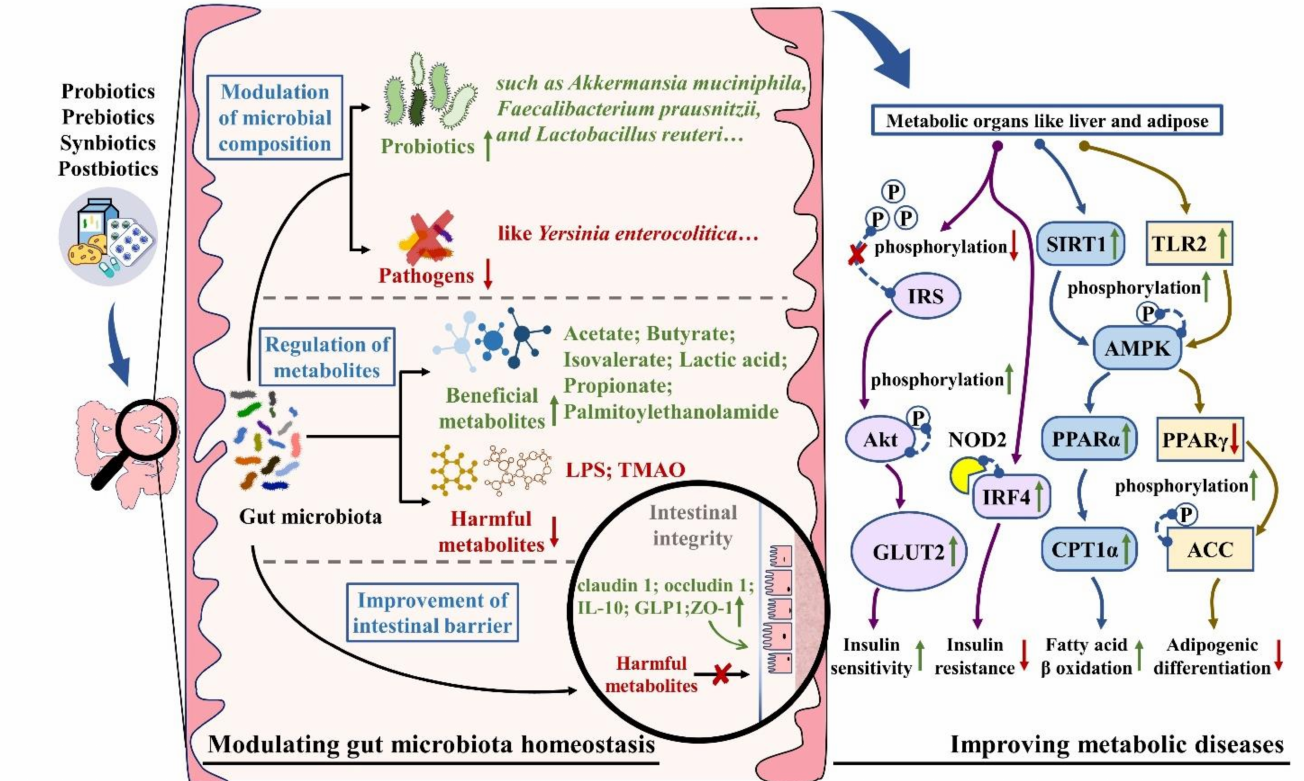
Figure 1. Mechanisms of PPSP on metabolic diseases targeting gut microbiota. PPSP directly alleviate metabolic diseases by regulating the abundances of beneficial and harmful bacteria. Besides, PPSP indirectly ameliorate metabolic diseases by promoting the production of acetate, propionate, butyrate, isovalerate, lactic acid, and palmitoylethanolamide, while suppressing the production of LPS, TMAO and reducing the bile acid pools. Moreover, the improvement of intestinal barrier function played an important role in attenuating metabolic diseases, with upregulating claudin 1, GLP1, IL-10, occludin 1, and ZO-1 expressions. These mechanisms collectively improve the whole metabolic system by targeting several pivotal molecular, such as upregulating IRS1-Akt-GLUT2, SIRT1-AMPK-PPAR α -CPR1 α , TLR2-PPAR γ -AMPK, and NOD-IRF4 signaling pathways. Abbreviation: ACC, acetyl-CoA carboxylase; Akt, protein kinase B; AMPK, adenosine monophosphate kinase; CPR1 α , carnitine palmitoyltransferase 1 α ; GLUT2, glucose transporter 2; IRF4, interferon regulatory factor 4; IRS1, insulin receptor substrate 1; LPS, lipopolysaccharide; NOD2, oligomerization domain-containing protein 2; PPAR α / γ , peroxisome proliferators activated receptor α / γ ; SIRT1, sirtuin 1; TLR2, Toll-like receptor 2; TMAO, trimethylamine-n-oxide; ZO-1, zonula